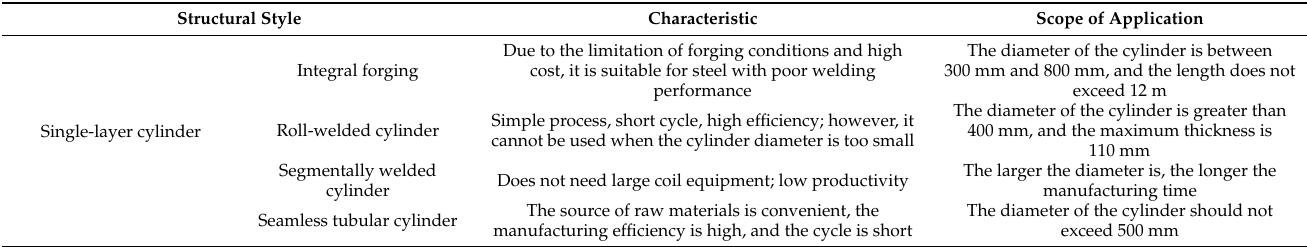
Figure 5. Bearing capacities of various cylindrical structures. Table 1. Structural characteristics and application range for each cylinder form.